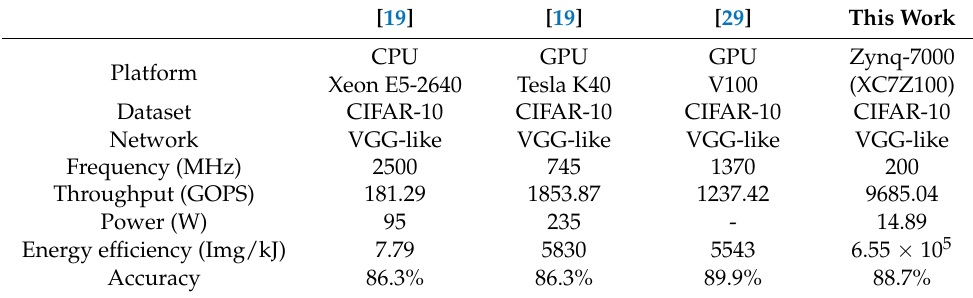
Table 3. Cross-platform